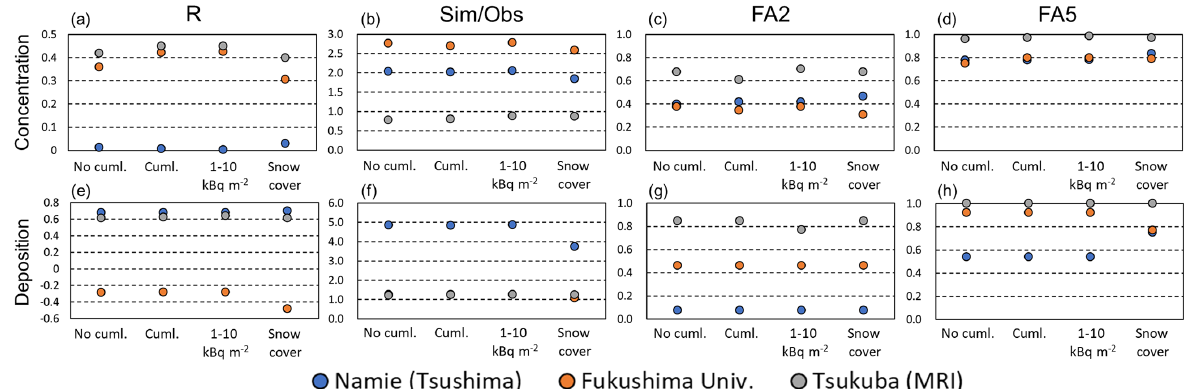
Figure 10. Summary of statistical measures between the observations and the simulations (dust plus forest) for various sensitivity tests, such as (from left to right) the correlation coefficient ( R ), simulation-to-observation median ratio (Sim / Obs), numerical fraction of data within a factor of 2 (FA2), and numerical fraction of data within a factor of 5 (FA5) for (top) the surface concentrations and (bottom) depositions at (blue) Namie (Tsushima), (orange) Fukushima, and (gray) Tsukuba. The four sensitivity tests are conducted for the supermicron case and consider no cumulus convection parameterization ([No cuml.]), the addition of the cumulus convection parameterization ([Cuml.]), cumulus convection plus emissions from grid boxes where the initial deposition amounts are 1–10kBqm − 2 ([1–10kBqm − 2 ]), and cumulus